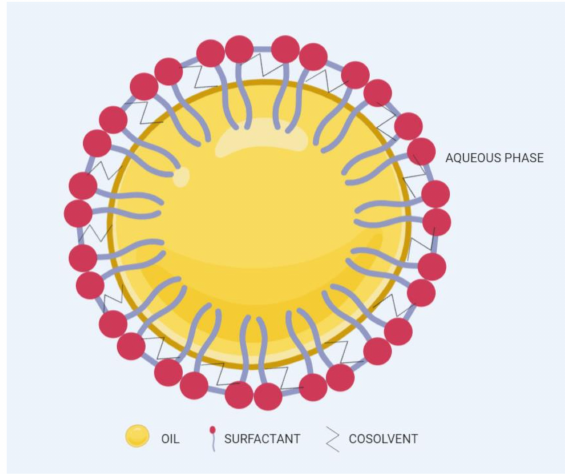
Figure 1. Typical structure of SNEDDSs after aqueous